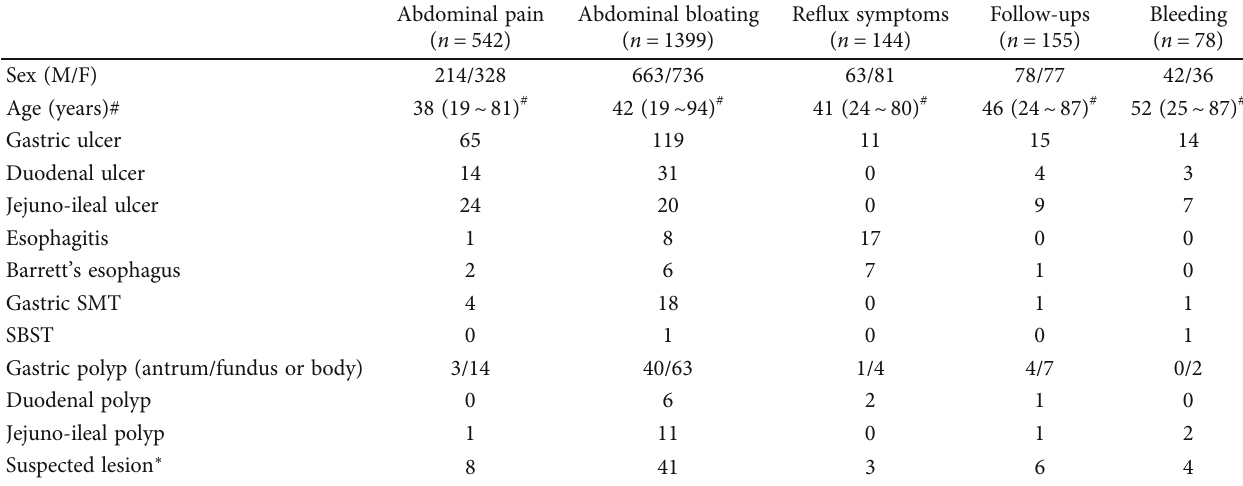
Table 2: Results of MCCG in di ff erent groups.